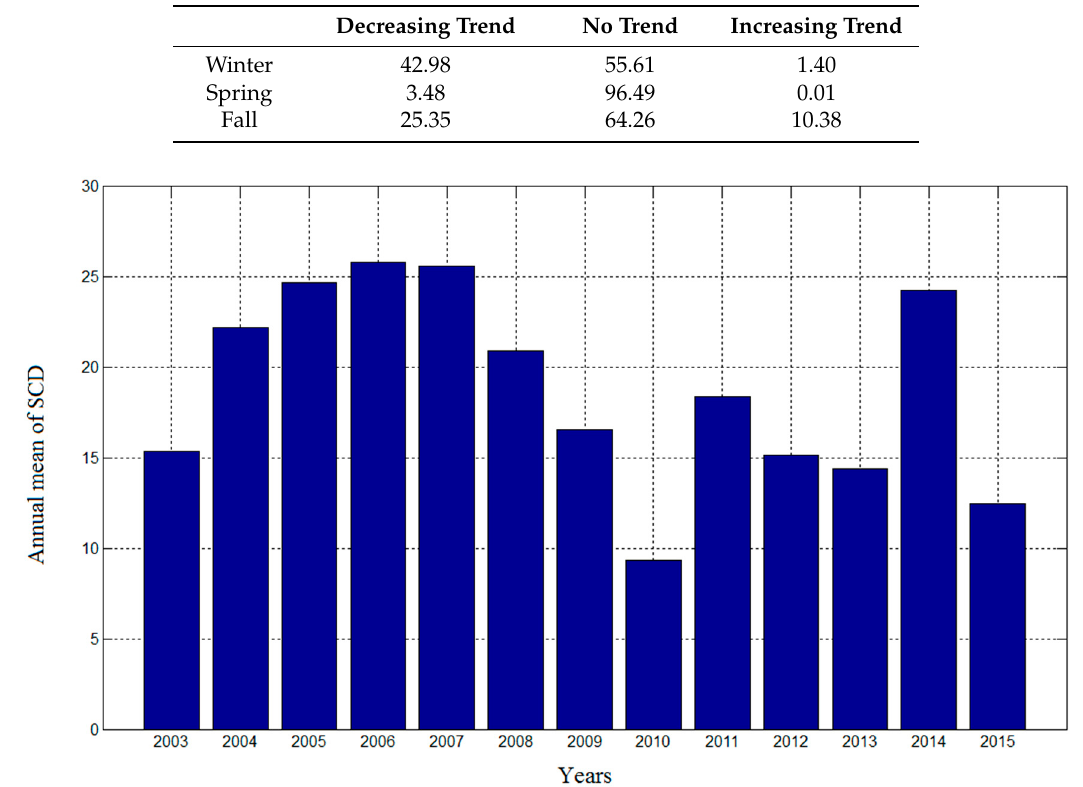
Figure 8. Annual time series of mean SCD from 2003 to 2015 in the Basin.